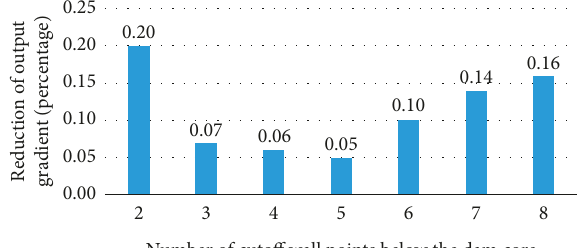
Figure 11: Percentage reduction of exit gradient in different po- sitions of the cutoff